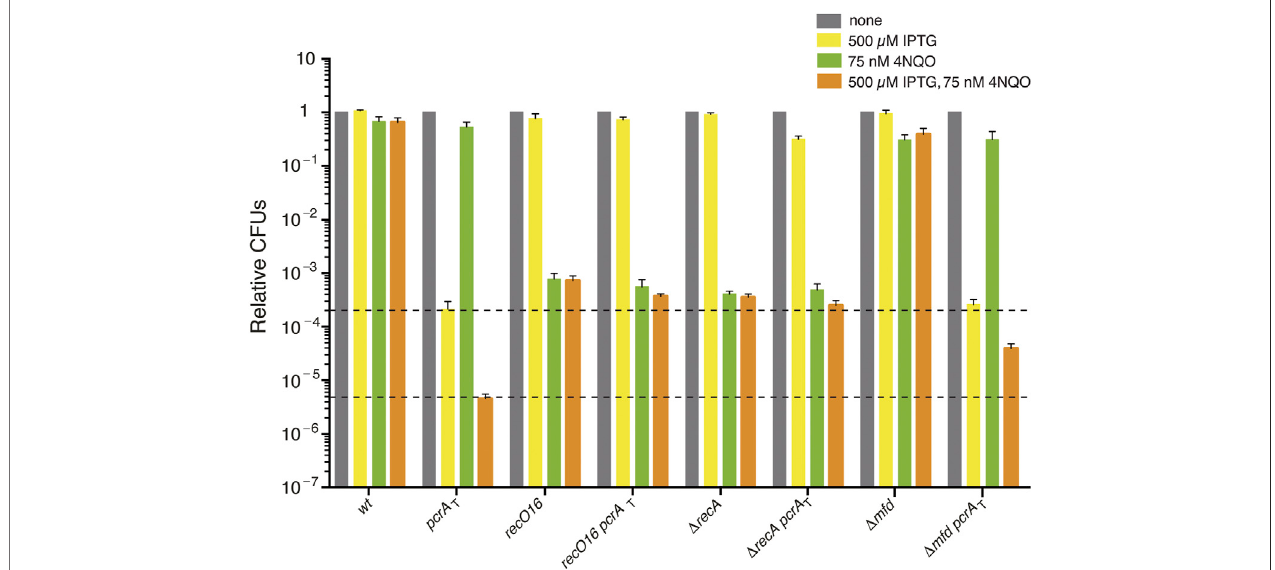
FIGURE 1 | The sensitivity of PcrA depleted cells to 4NQO is partially suppressed by recO , recA , or mfd inactivation. Log phase cultures of wt , single ( pcrA T , recO 16, Δ recA , or Δ mfd ) and double mutant ( pcrA T recO 16, pcrA T Δ recA , or pcrA T Δ mfd ) strains were diluted, plated on LB agar (grey bars), LB agar + 500 μ M IPTG (yellow bars), LB agar + 75 nM 4NQO (green bars), or LB agar + 500 μ M IPTG + 75 nM 4NQO (orange bars) and incubated overnight at 37 ° C. Experiments were performed at least four times. The dotted lines mark the upper and lower limit of the cell viability rate upon PcrA depletion. Data are shown as mean fractional survival